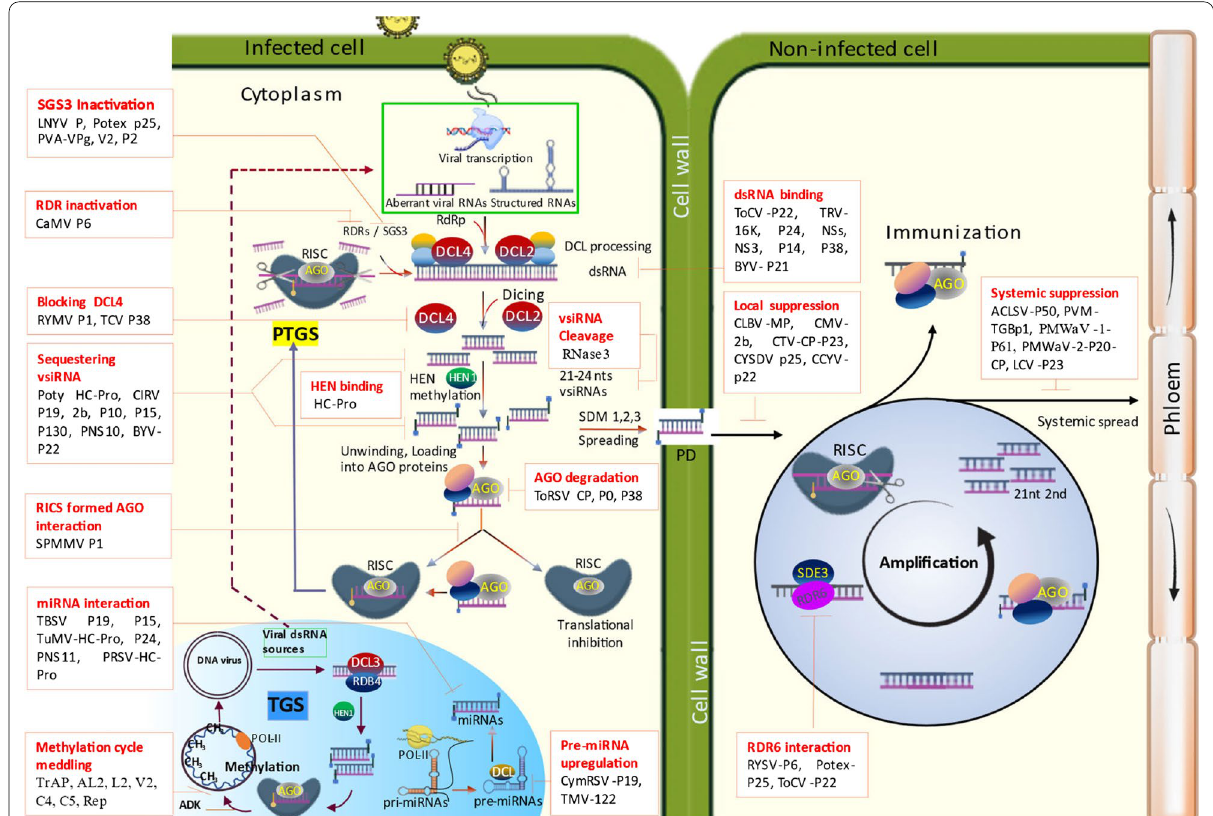
Fig. 2 The antiviral RNA silencing model and VSRs with diverse sets of strategies for battling against RNA silencing [adapted from Burgyán and Havelda (2011), Csorba et al. (2015), Gaffar and Koch (2019)]. An antiviral response is initiated with the biogenesis of 21–24 nt vsiRNAs and miRNAs, the silencing molecules that are produced through DCL processing (vsiRNAs are produced primarily by DCL4 and secondarily by DCL2 in the cytoplasm, whereas miRNAs are synthesized in the nucleus by DCL1). These silencing molecules are stabilized by the HEN1 methylation process and subsequently loaded into AGOs to form an RNA-induced silencing complex (RISC), followed by the effector phase of post-transcriptional gene silencing (PTGS) completed through viral RNA cleavage or translational inhibition. To amplify the antiviral RNA silencing response, AGO-sliced products and aberrant viral transcripts or RNAs are used as templates for RDR complexes employing RNA-helicases (SGS3 and SDE5), the cofactors of RDRs triggered pathways. Transcriptional gene silencing (TGS) is triggered by the production of 24-nt vsiRNAs via DCL3 processing (nucleus) in the case of DNA virus infection. HEN1-methylated 24-nt vsiRNAs are loaded into AGO4 to complete TGS after methylation of the viral genome through a DNA methylation cycle mediated by Pol II, ADK, SAHH, and SAMS. VSRs that interfere with PTGS or TGS are presented in boxes along the sides of the figure. The lines indicate the target site at which VSRs interact with the antiviral